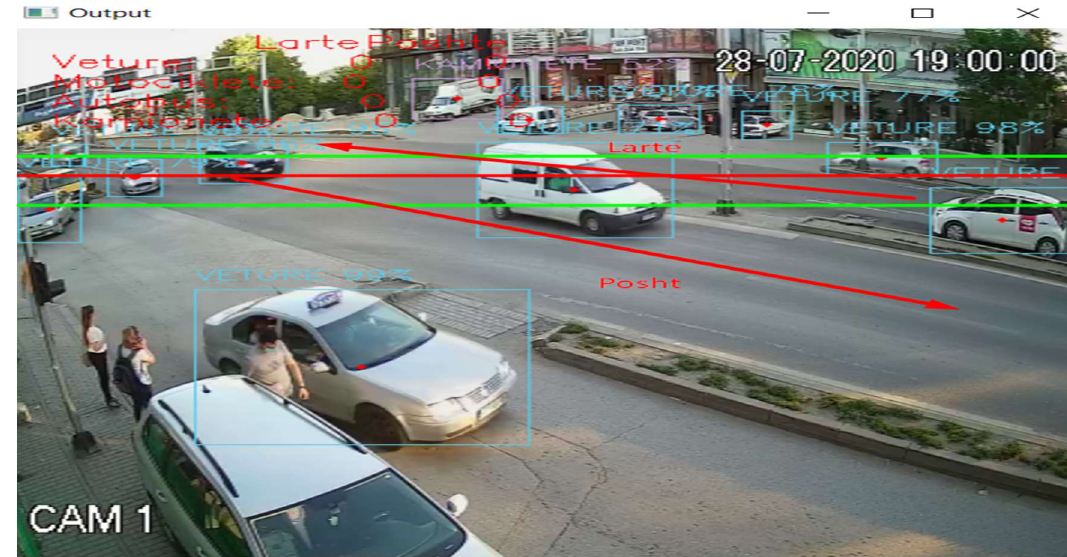
Figure 5. Traffic count from camera and data processing in program (time: 19:00–19:15).